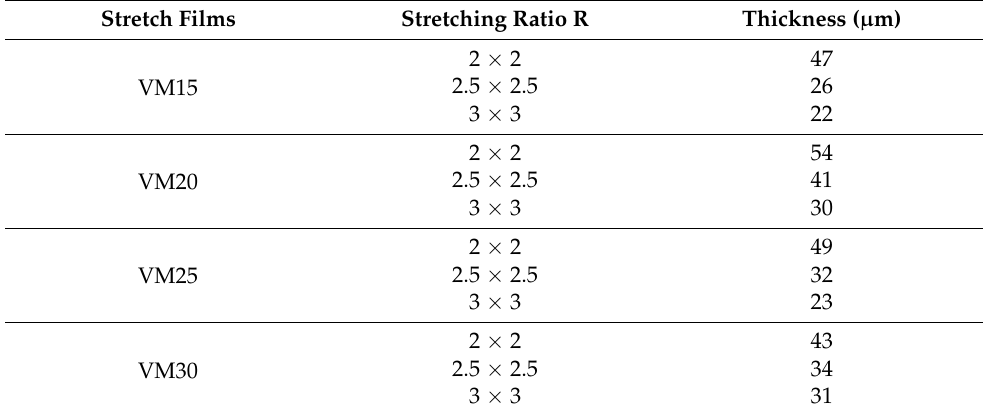
Table 2. The thickness of biaxial stretch